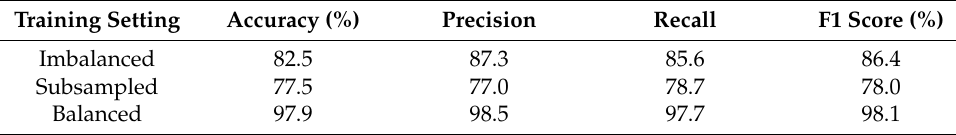
Table 3. Performance evaluation of ceramic substrate